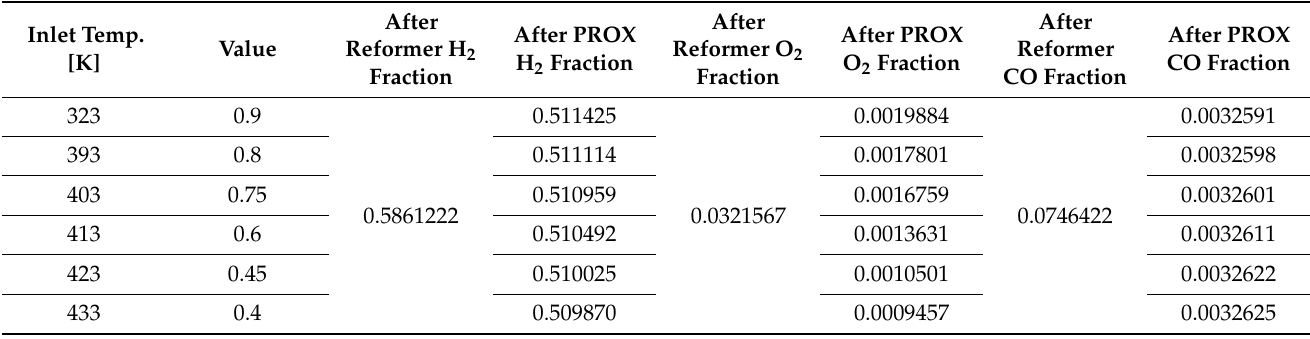
Table 3. PROX selectivity according to inlet temperature.